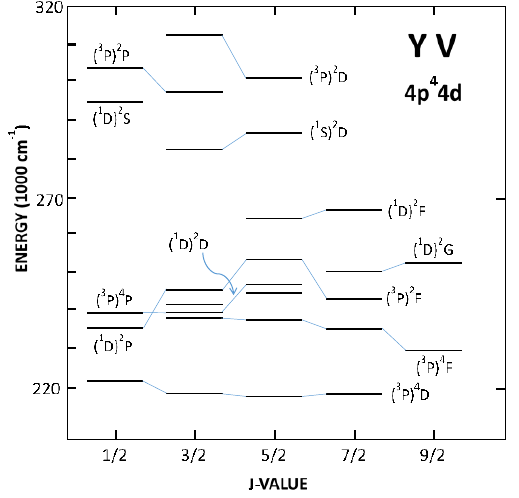
Figure 2. Structure of the 4s 2 4p 4 4d configuration of Y V.